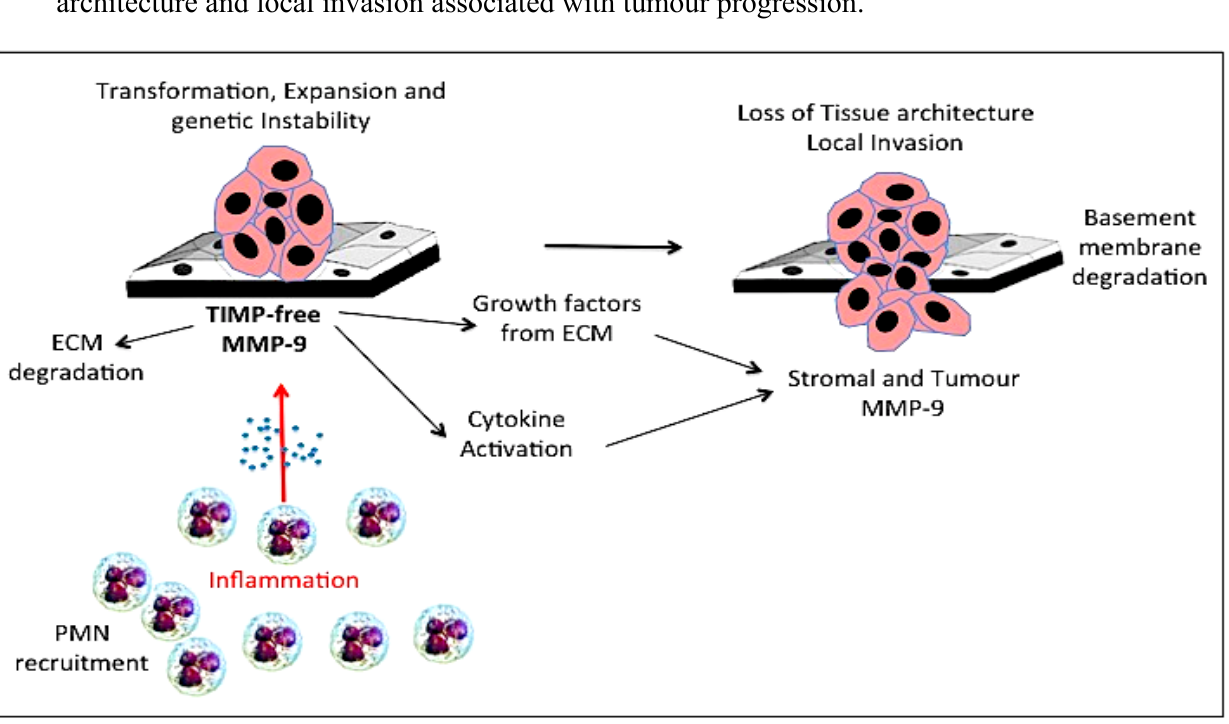
Figure 5. Representation of the roles played by inflammatory polymorphonuclear leukocyte (PMN)-derived tissue inhibitor of metalloproteinase (TIMP)-free gelatinase B/MMP-9, gelatinase B/MMP-9 of stromal and tumour origin, in the loss of tissue architecture and local invasion associated with tumour